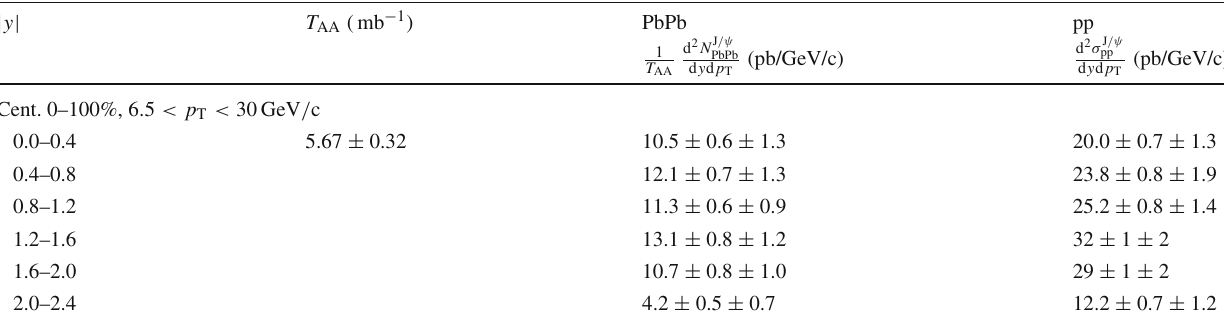
Table 6 The nonprompt J /ψ fiducial cross section in bins of absolute rapidity, measured in PbPb and pp collisions at 2.76TeV within the muon acceptance defined by Eq. (4), and the nuclear overlap function ( T AA , with its systematic uncertainty). Listed uncertainties are statis-